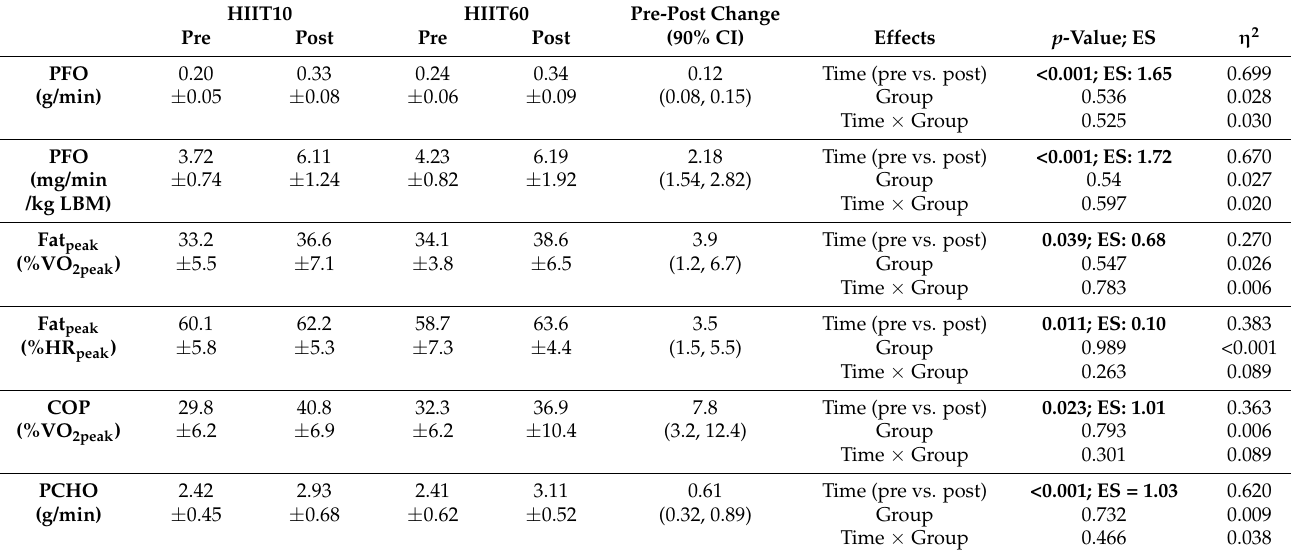
Table 4. Changes in carbohydrate and fat oxidation indices before (pre) and after (post) the intervention for the two training groups (HIIT10 and HIIT60).